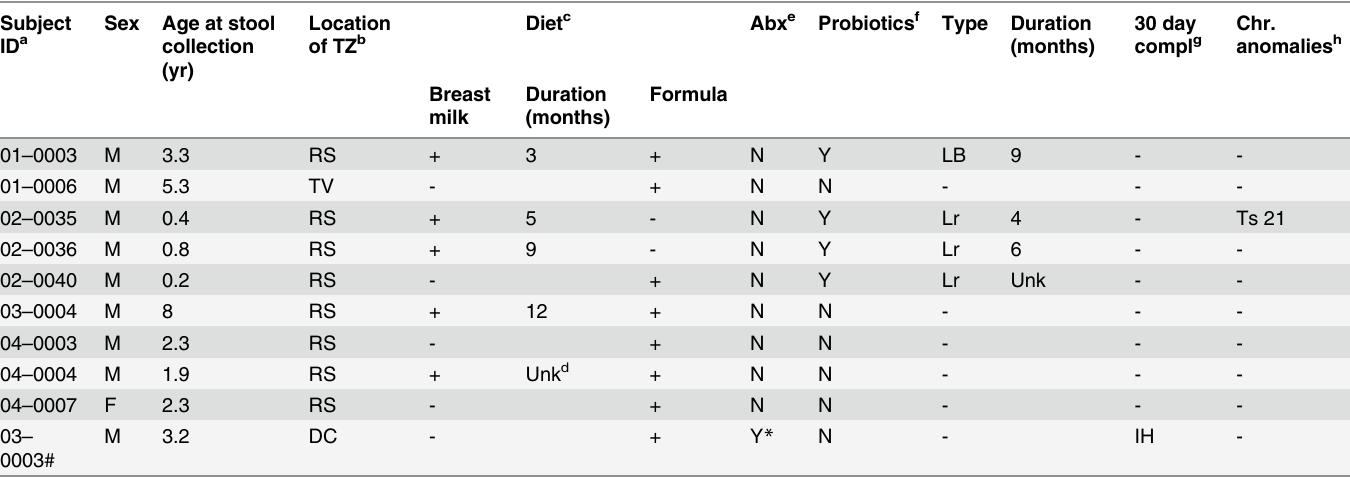
Table 1. Patient Characteristics: HSCR